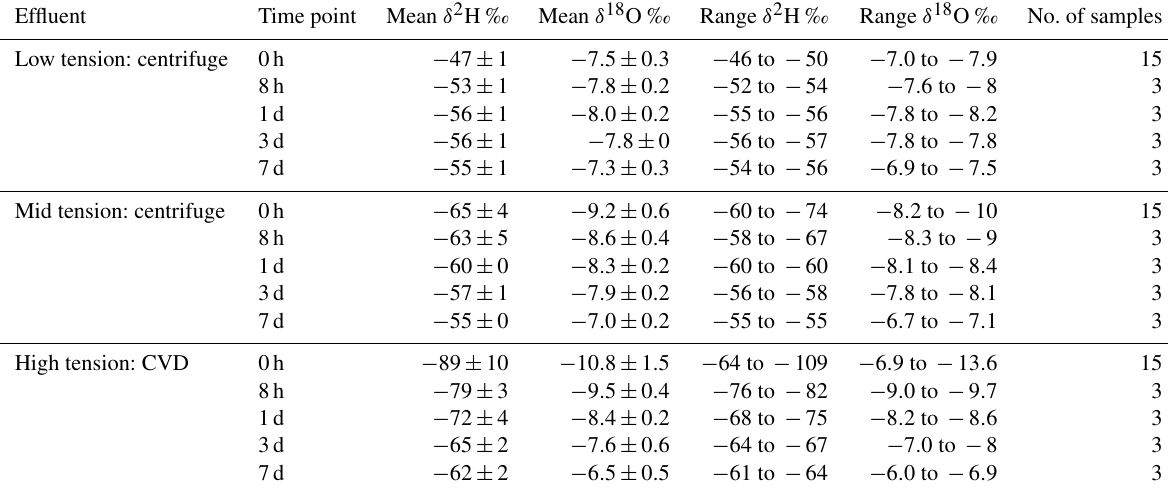
Table 1. The mean, standard deviation, and range of isotope values for each extracted water sample from each time point. Effluent